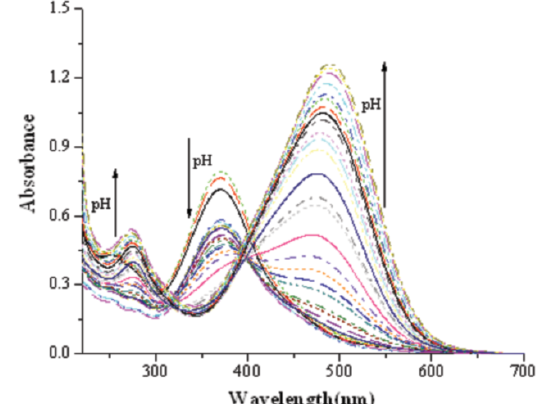
Figure 2. Titration spectra of 5.0×10 -5 mol L -1 4-[(4-nitrophenyl) diazenyl]-l,2-benzenediol (D2).